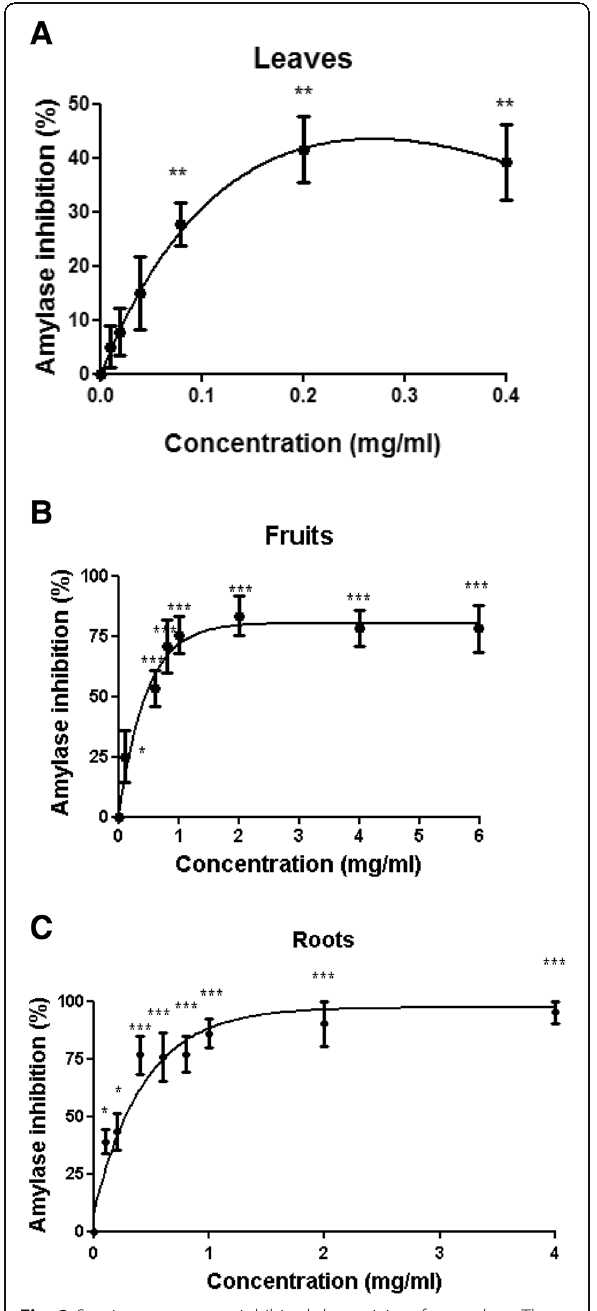
Fig. 3 S. spinosum extracts inhibited the activity of α -glucosidase. The activity of α -glucosidase in the presence or absence of leaves ( a ), fruits b or roots c extracts was measured as described in Materials and Methods . Results are mean ± SEM of % inhibition of 5 independent experiments. * p < 0.05, ** p < 0.005, *** p < 0.0005 compared to untreated cells by Student ’ s t